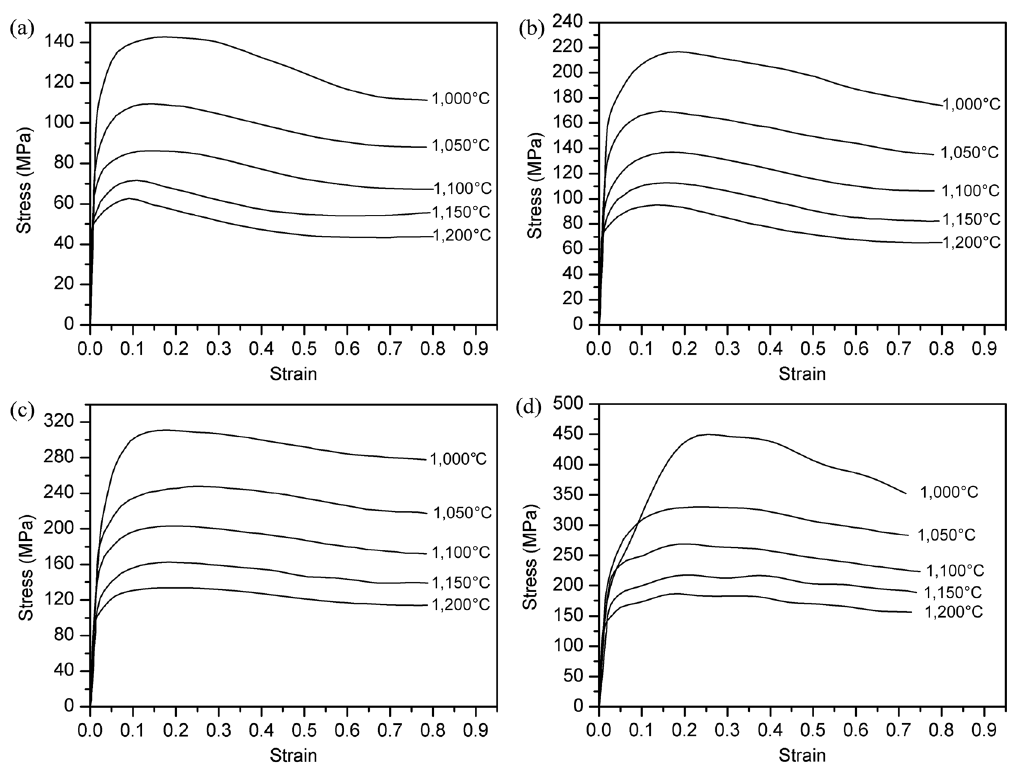
Figure 2: Stress – strain curves at various temperatures with strain rates of (a) 0.01 s – 1 , (b) 0.1 s – 1 , (c) 1 s – 1 , (d) 5 s – 1